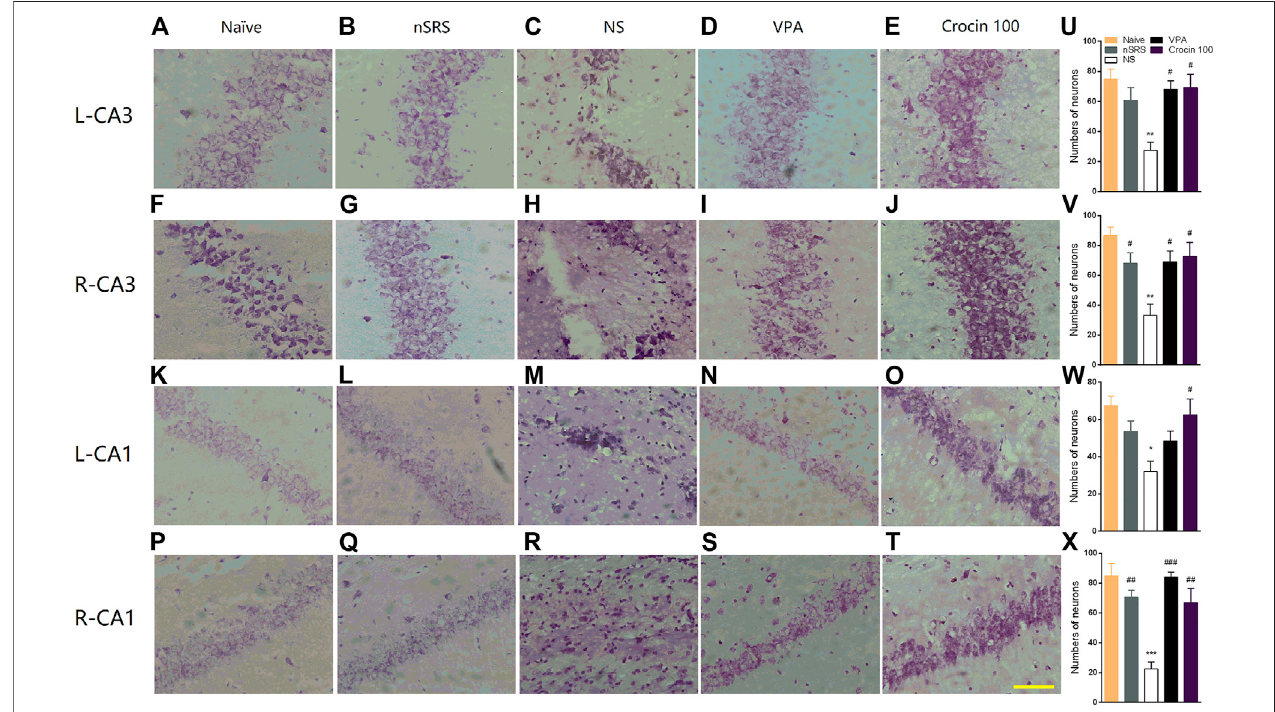
FIGURE 6 | Effects of crocin on the neural damage in the hippocampus region in each group of mice. (A – E) H-E staining of neurons in the left hippocampal CA3 region; (F – J) H-E staining of neurons in the right hippocampal CA3 region; (K – O) H-E staining of neurons in the left hippocampal CA1 region; (P – T) H-E staining of neurons in the right hippocampal CA1 region. Bar = 200 μ m. (U – X) The quanti fi cation of survival neurons in left CA3, right CA3, left CA1 and right CA1 ( n = 3 for each group, x (cid:1) ±S.E.M.). SRS, spontaneousrecurrent seizures; nSRS, non-SRS; NS,normal saline; VPA,sodium valproate. Values arefrom 3independent experiments. * p < 0.05,** p < 0.01,*** p < 0.001,compared withnaivegroup; # p < 0.05, ## p < 0.01, ### p < 0.001,comparedwithNSgroup(withSRS).One-wayANOVAwasusedfor (U – X) , followed by Tukey ’ s